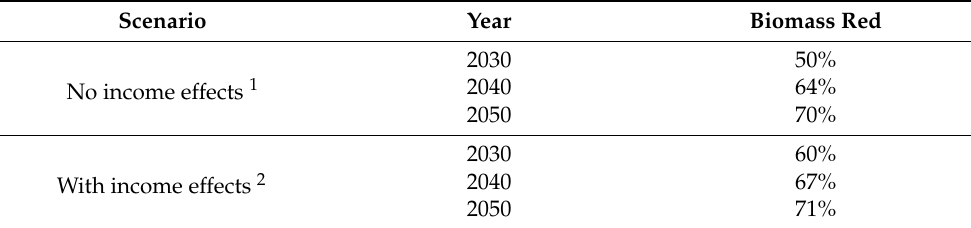
Table 5. Biomass reduction according to the year and scenario of